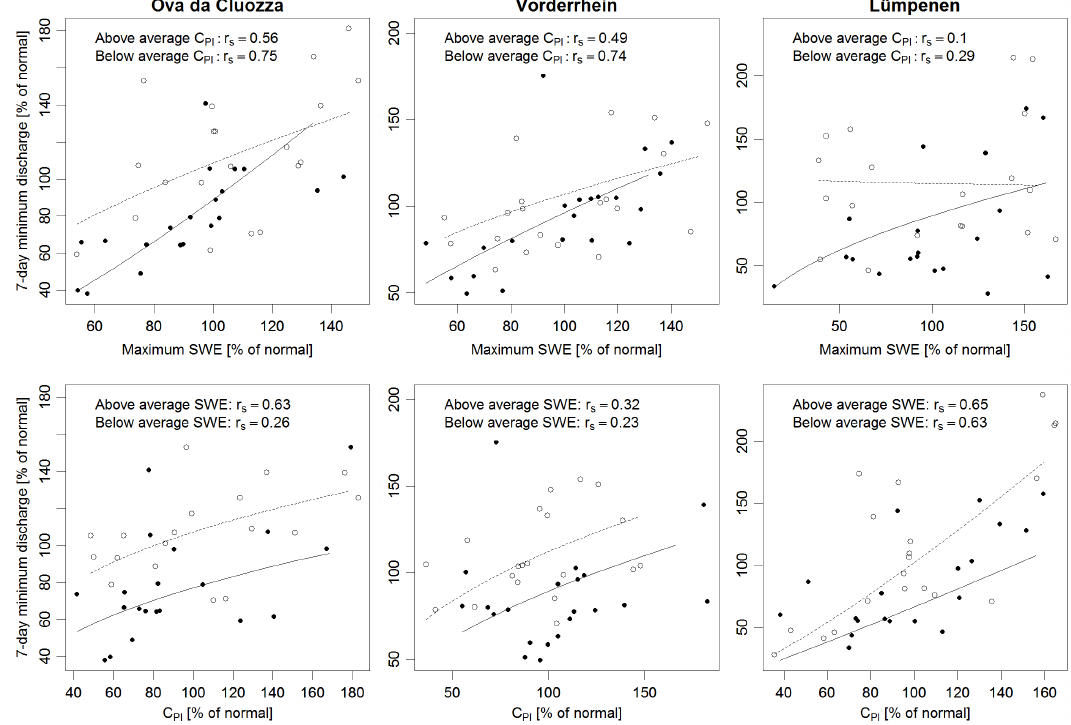
Figure 8. Top panels: 7-day minimum discharge in July against maximum SWE for years grouped according to the current precipitation in- dex C PI . Bottom panels: 7-day minimum discharge in July against current precipitation index C PI for years grouped according to maximum SWE. Lines represent the minimum discharge occurring with a 50% probability; r s represents Spearman rank correlation coefficient. Trans- parent circles and dashed lines indicate years with above-average values and black points and solid lines indicate years with below-average